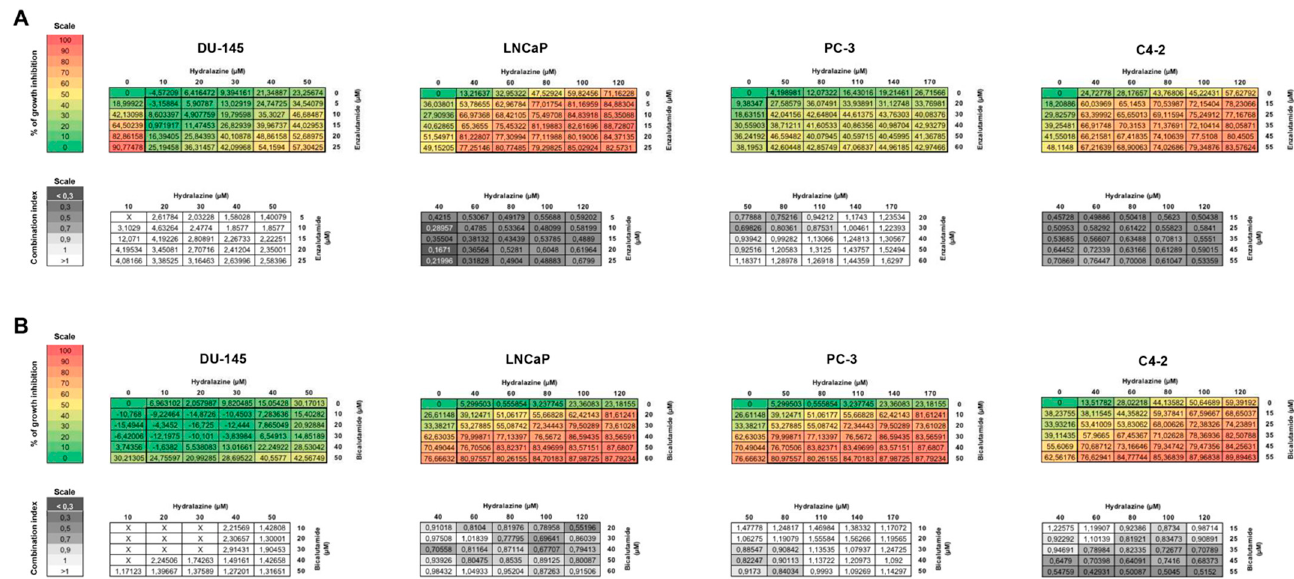
Figure 2. Combination matrices of hydralazine and enzalutamide ( A ) or bicalutamide ( B ) in PCa (prostate cancer) cell lines. The CompuSyn software was used to calculate the drug combination index, with a value lower than 1 indicating synergistic effects, a value of 1 denoting an additive effect, and a value higher than 1 implying antagonistic effects. (X—impossible to calculate).